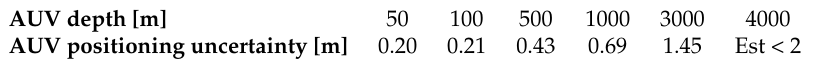
Table 13. Estimated position uncertainties related to